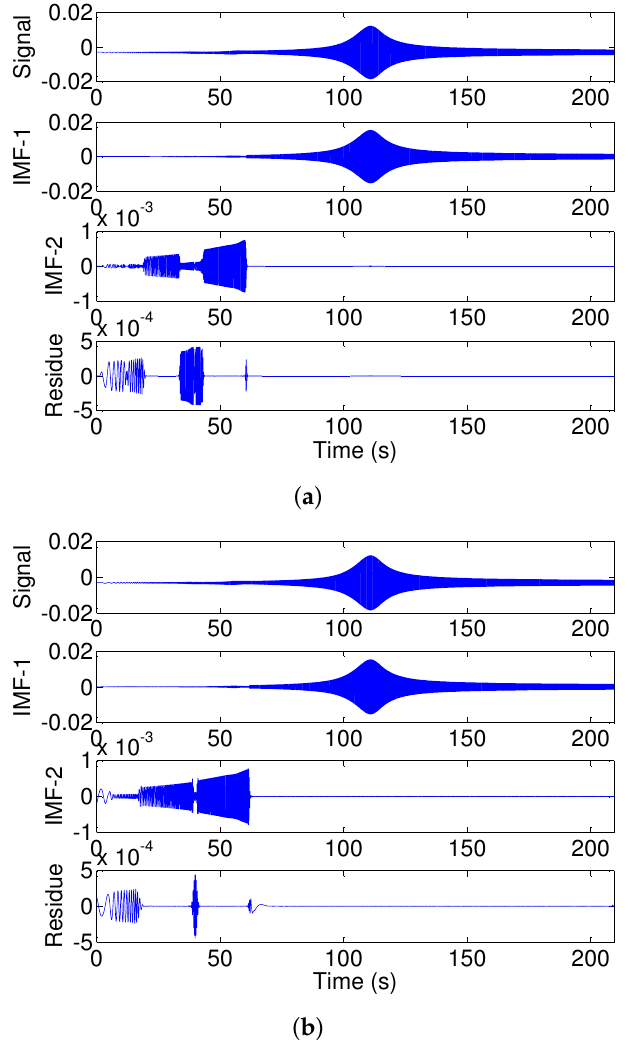
Figure 10. Decomposition of the vertical transient response of the system with a deep crack, ( µ = 1 ) , based on ( a ) improved EMD and ( b ) EMD algorithms, the shaft speed changes from 0 to 16.66 Hz (1000 rpm) with a constant acceleration rate of a r = 0.5 rad s 2